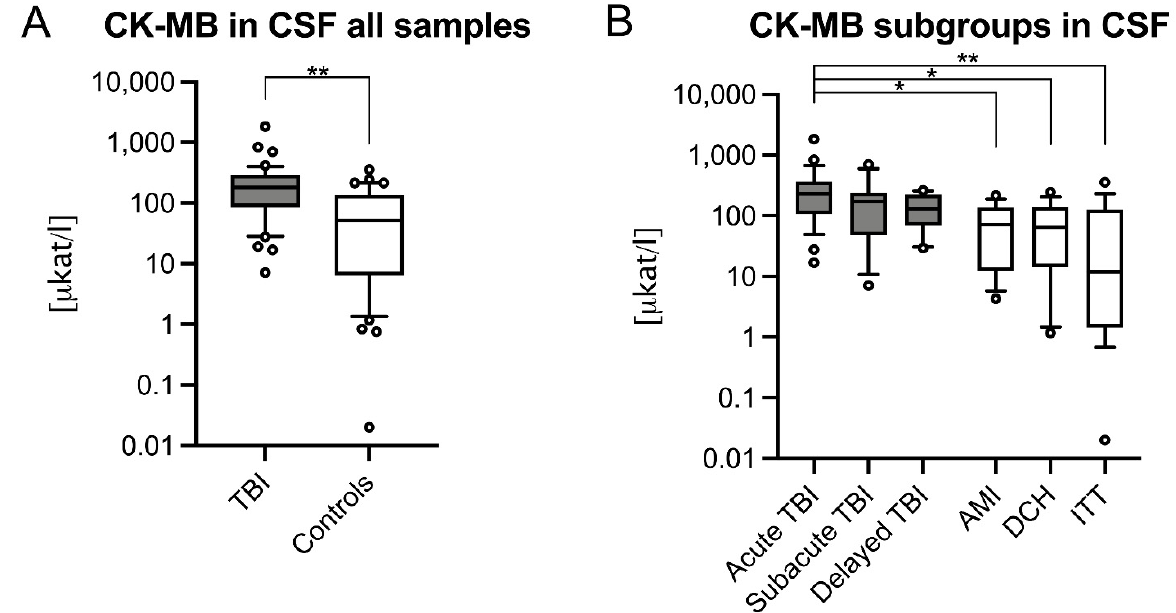
Figure 3. Heart-type creatinine kinase (CK–MB) levels in cerebrospinal fluid (CSF) samples of ( A ) all traumatic brain injury (TBI), control cases and ( B ) their respective subgroups are depicted logarithmically. Whiskers indicate the 10th and 90th percentile; circles show outliers. AMI, acute myocardial infarction; CSF, cerebrospinal fluid; DCH, diffuse cerebral hypoxia; ITT, isolated torso trauma; *, p ≤ 0.05; **, p ≤